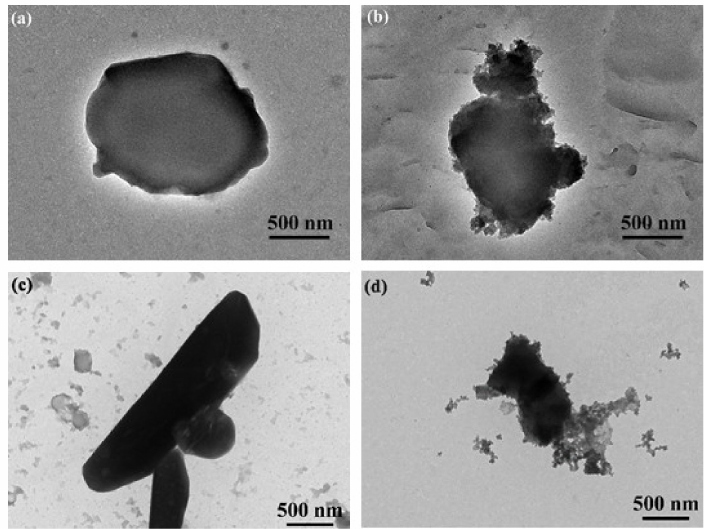
Figure 1. TEM images of ( a ) Az-WDG, ( b ) Az-WDG-TA, ( c ) Av-WDG, and ( d ) Av-WDG-TA. The scale bar is 500